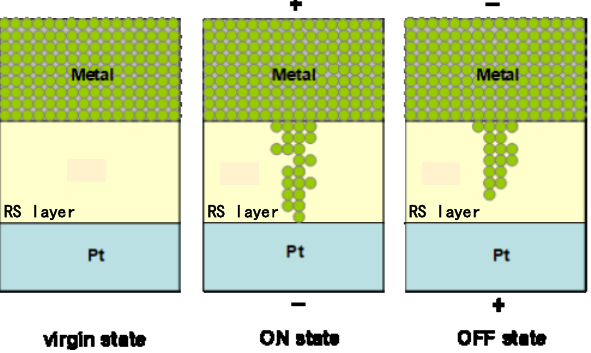
Figure 8. Schematic diagram for the mechanism of the resistive switching effect in metal/GO/Pt memory cells [132] .